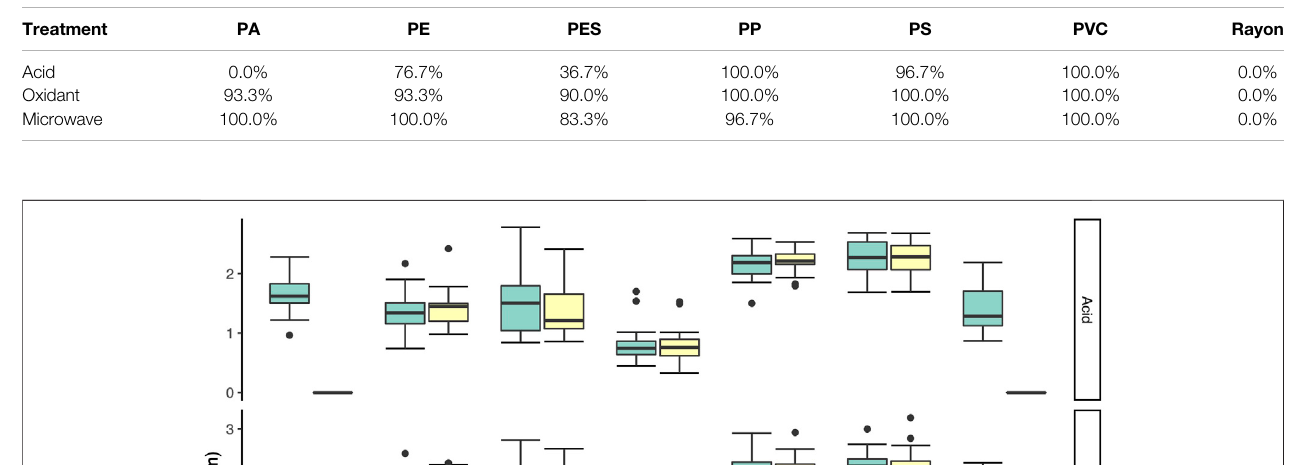
Average blue value